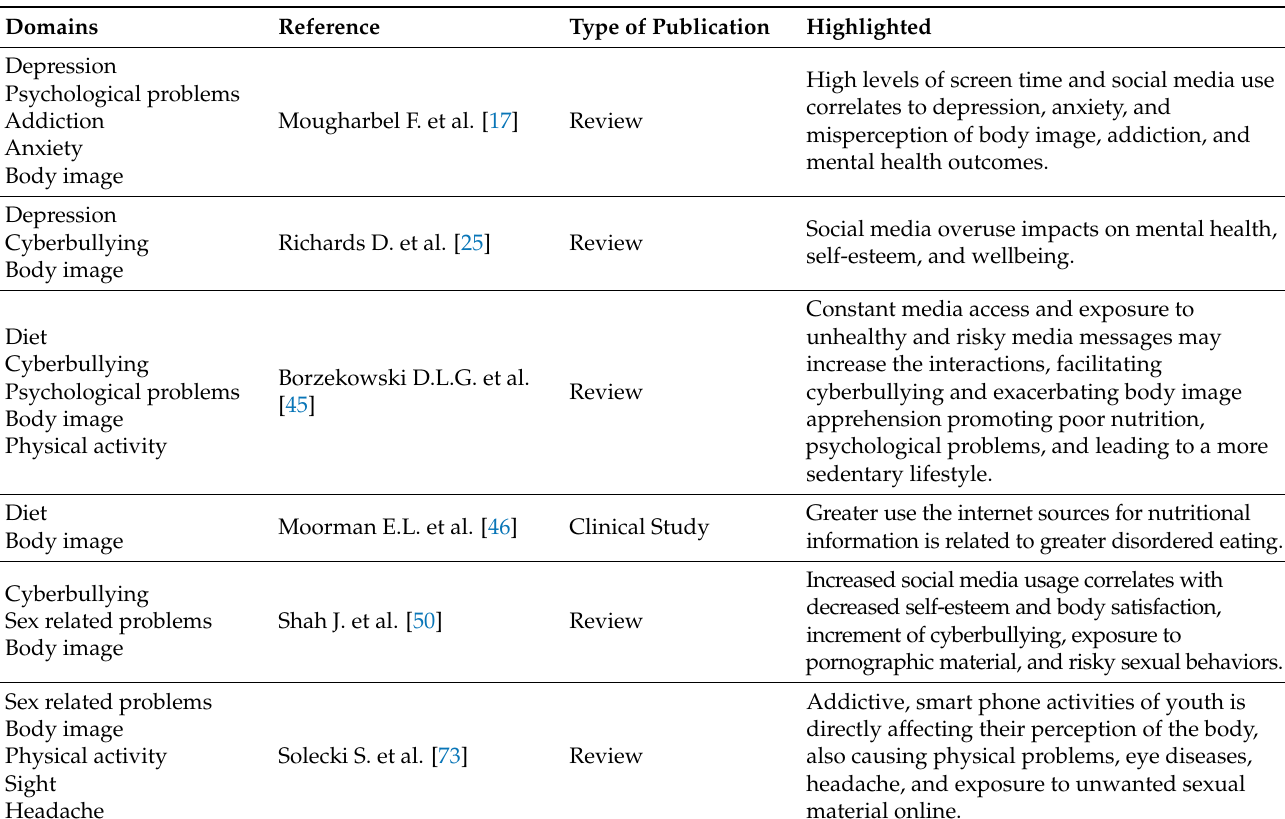
Table 11. Social media and body